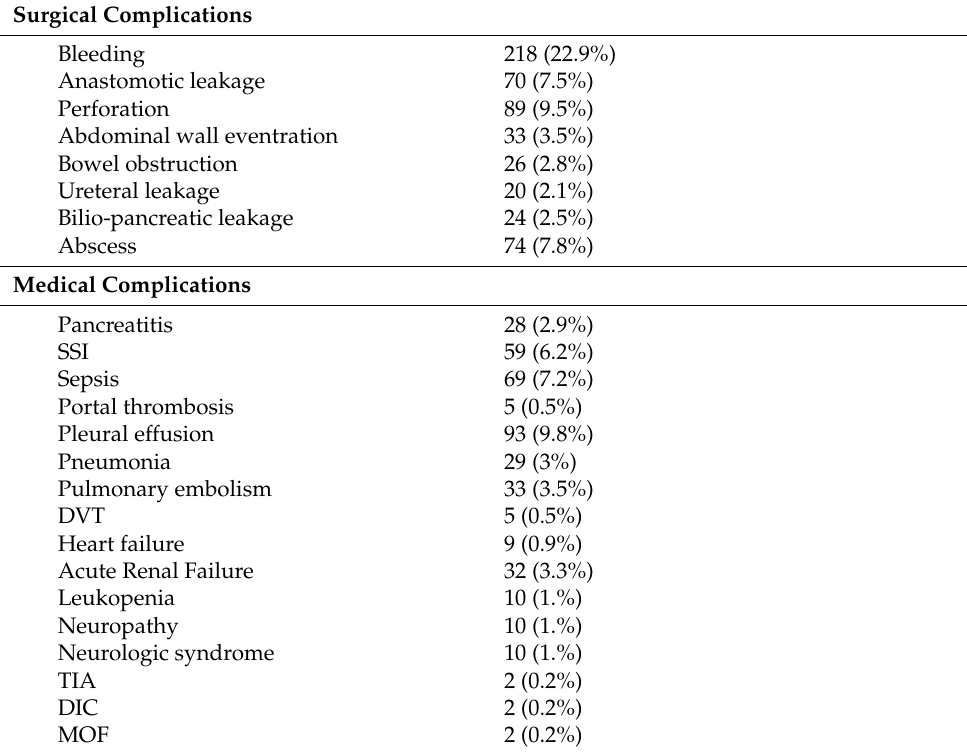
Table 4. Complications, N (%) (total 952